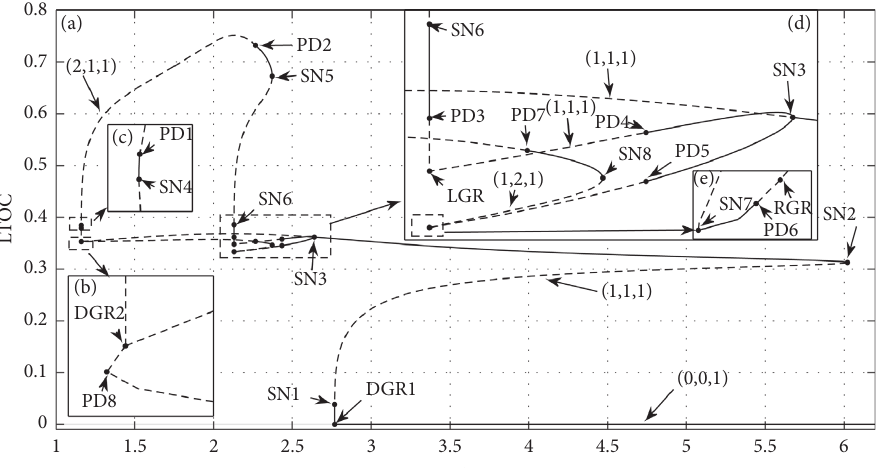
Figure 2: The result of the numerical continuation of the period-1 solution with respect to the frequency ω . The black solid and black dashed orbits denote stable and unstable solutions, respectively. Bifurcation points are marked by black